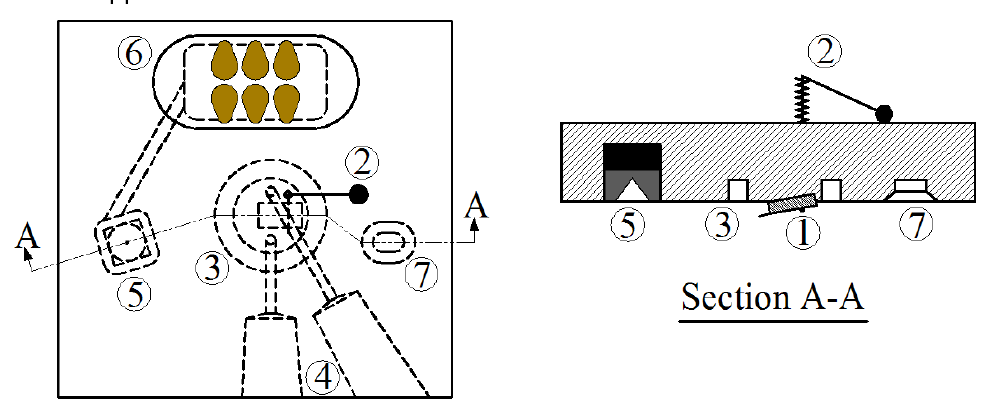
Figure 2. Schematic of a fluid cell. In this picture (1) is the cantilever, (2) is the clip and spring, (3) is the circular groove for o-ring, (4) are the inlet and outlet channels for exchanging liquids, (5) is the moving support, (6) is the connecting chip, and (7) is the fixed support.